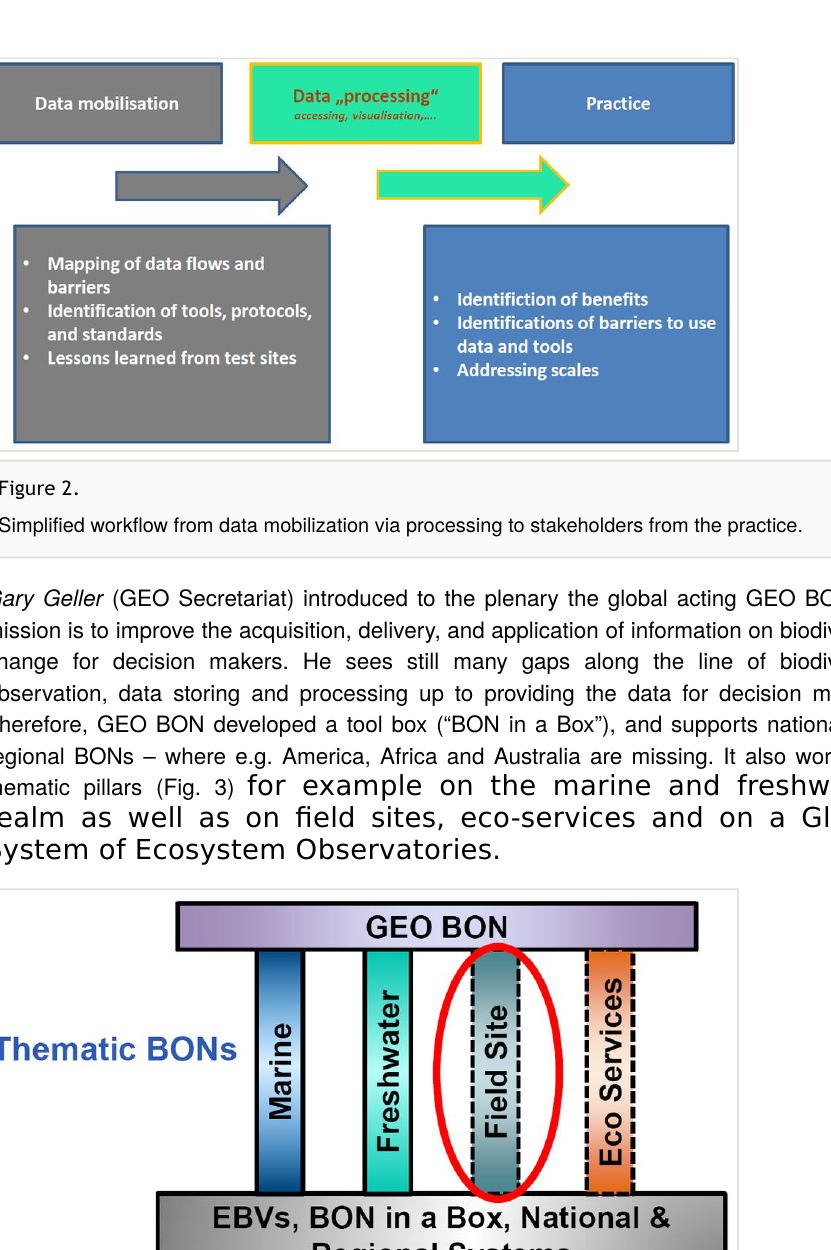
Figure 3. Thematic pillars of GEO BON (Gary Geller, GEO Secretariat,